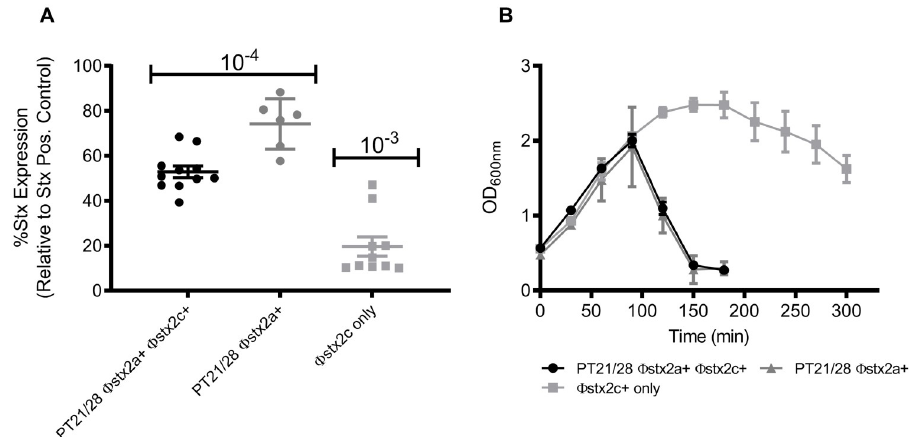
Fig 1. Comparison of Stx2 toxin levels and lysis for PT21/28 F stx2a + and F stx2c encoding strains. (A) Total Stx2 toxin produced by PT21/28 F stx2a + F stx2c + (n = 10), PT21/28 F stx2a + (n = 6) and F stx2c (n = 10) carrying strains measured by ELISA assay after 24 hrs induction with MMC. Values are expressed relative to a Stx positive control used in each assay. The individual strain values and mean ± SEM are shown. 10 − 4 and 10 − 3 indicate the dilution factor for the samples used for the Stx2 toxin ELISA assay. (B) Lysis of PT21/28 F stx2a + F stx2c + (n = 10) (black circles), PT21/28 F stx2a + (n = 6) (grey triangle) and F stx2c (n = 10) (grey square) encoding strains was measured spectrophotometrically as a drop in culture OD 600nm . The mean OD 600nm values ± SEM are plotted.